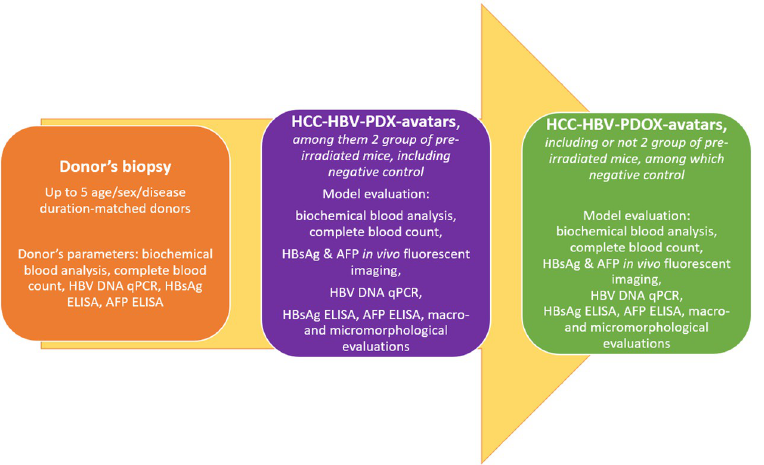
Fig 2. Graphics pipeline of animal protocols